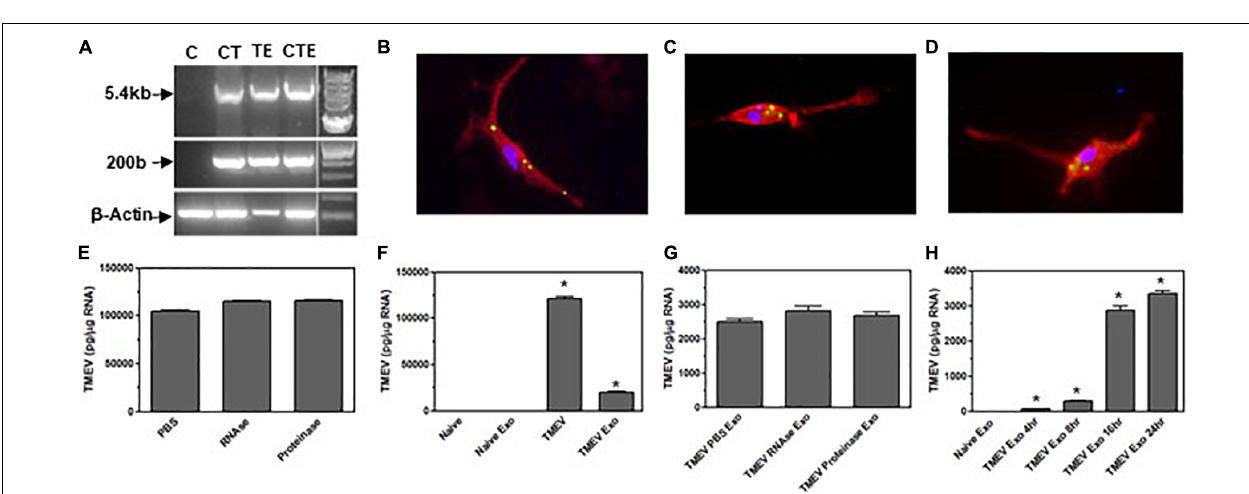
FIGURE 2 | Exosomes from TMEV-infected microglia contain viral RNA that is transferred to bystander microglia. (A) Microglia were infected with TMEV and exosomes were isolated (lane TE). Microglia (1 × 10 6 ) were uninfected (lane C), infected with TMEV (lane CT), or incubated with exosomes (100 µ g) from TMEV-infected microglia (lane CTE). The cells were lysed 24 h later, RNA isolated, converted to cDNA, and used in PCR analysis with primers for TMEV long (5.4 kbp) or short (200 bp) products or with primers for β -actin. (B) Exosomes isolated from TMEV-infected microglia were fluorescently labeled with 2 µ M CFSE (green). The exosomes were placed in culture with naive microglia for 2 h, and the microglia were fixed and incubated with fluorescently labeled antibody for CD11b (red). Exosomes isolated from TMEV-infected microglia were incubated with RNA stain (green) and placed on microglia for 2 h (C) or 4 h (D) . Microglia were fixed and incubated with fluorescently labeled antibody for CD11b (red). Cells were analyzed by confocal microscopy. (E) Exosomes from TMEV-infected microglia were isolated and control treated (PBS), RNAse treated, or proteinase treated. The RNA was isolated from the exosomes, converted to cDNA, and used in real time PCR with primers for TMEV. (F) Microglia were uninfected (naïve) or infected with TMEV. Microglia were incubated with exosomes isolated from TMEV-infected microglia or uninfected microglia. The microglia were lysed 24 h later, RNA isolated, converted to cDNA, and real time PCR conducted with primers for TMEV. (G) Exosomes were isolated from TMEV-infected microglia and control treated (PBS), RNAse treated or proteinase treated prior to putting the exosomes into culture with naïve microglia. The microglia were lysed 24 h later and analyzed by real time PCR for TMEV. (H) Exosomes were isolated from TMEV-infected microglia and placed on naïve microglia. After 4 h, the exosomes were removed and the cells were washed and incubated for an additional 0, 4, 12, or 20 h before being lysed and analyzed by real time PCR for TMEV. Significant difference was determined by one way ANOVA and Bonferroni’s multiple comparison test (* p < 0.001) based on expression by naïve microglia. These are representative graphs from one experiment of six independent repeated experiments.